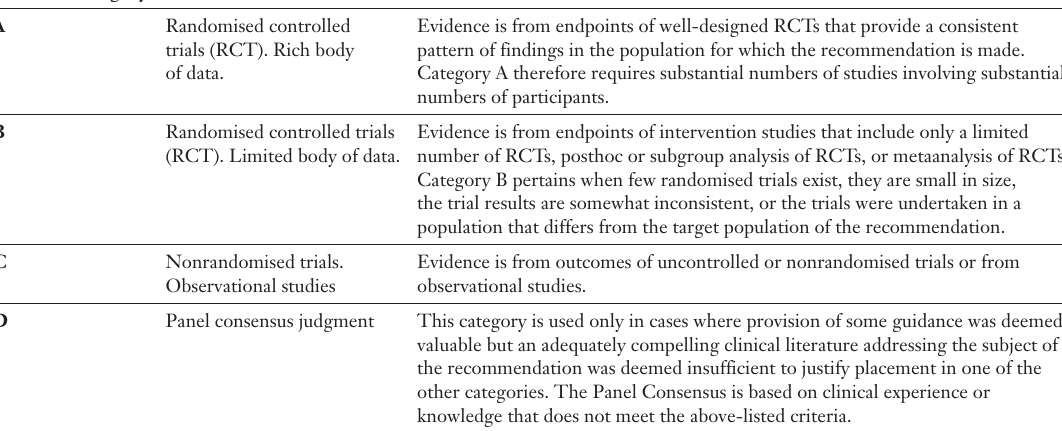
Description of levels of